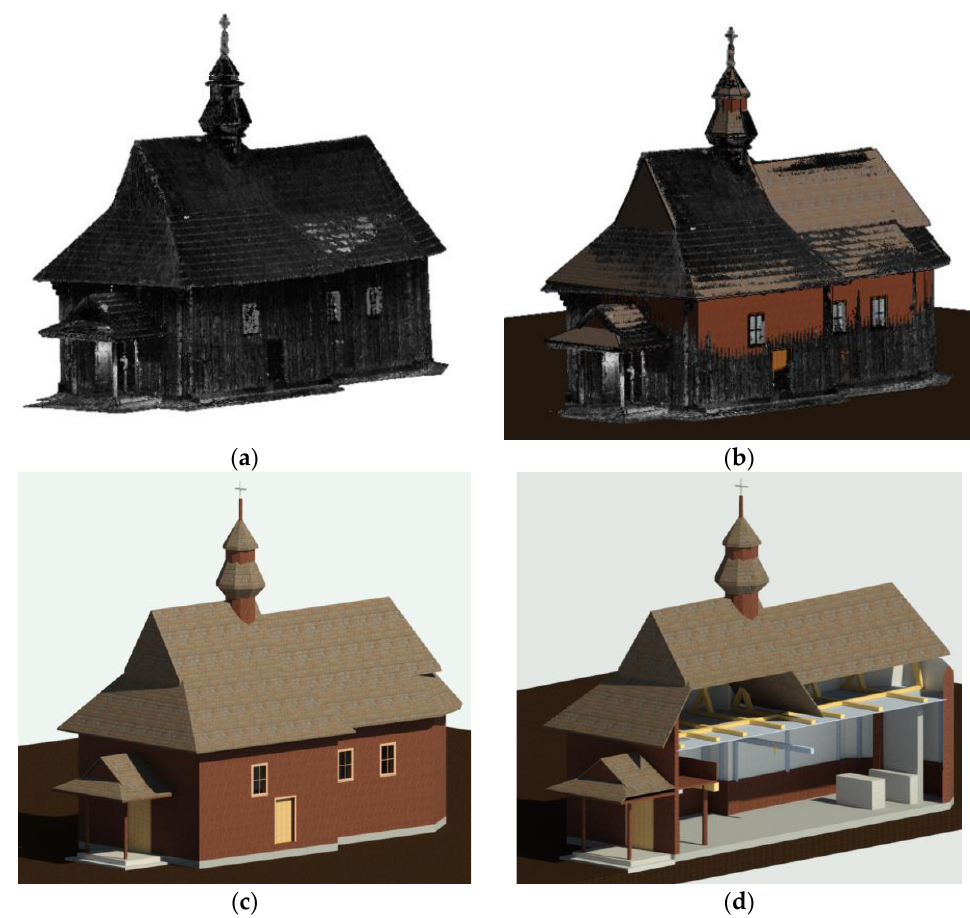
Figure 11. Work results for the chapel: ( a ) comprehensive point cloud with TLS-UAV integration; ( b ) generated model based on a point cloud; ( c ) visualization of the HBIM model; ( d ) visualization of the cross-section (interior) of the building.